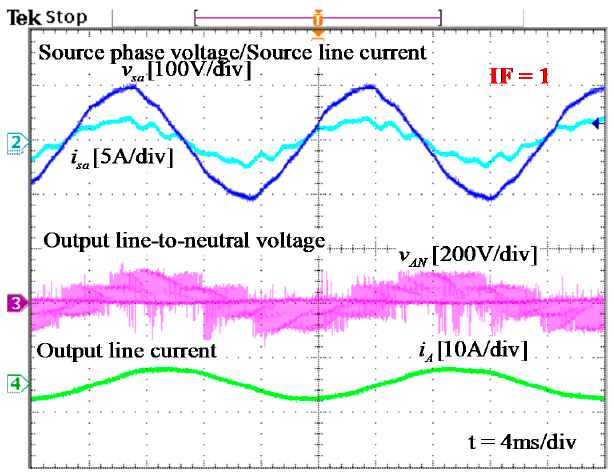
Figure 13. Source phase voltage/source current, output line-to-neutral voltage, and output line current at